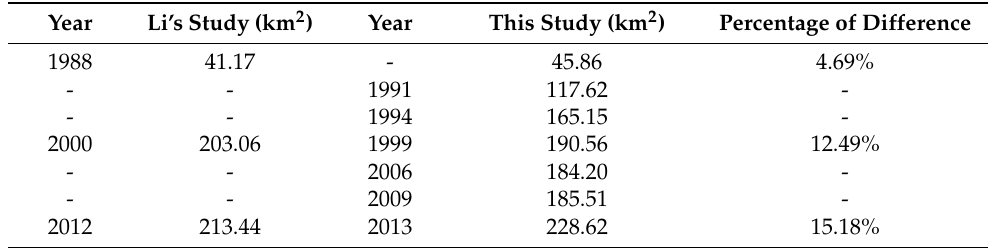
Table 3. Comparison of the pond changes between Li’s study and this study in Guangzhou for the period 1988 to 2013.